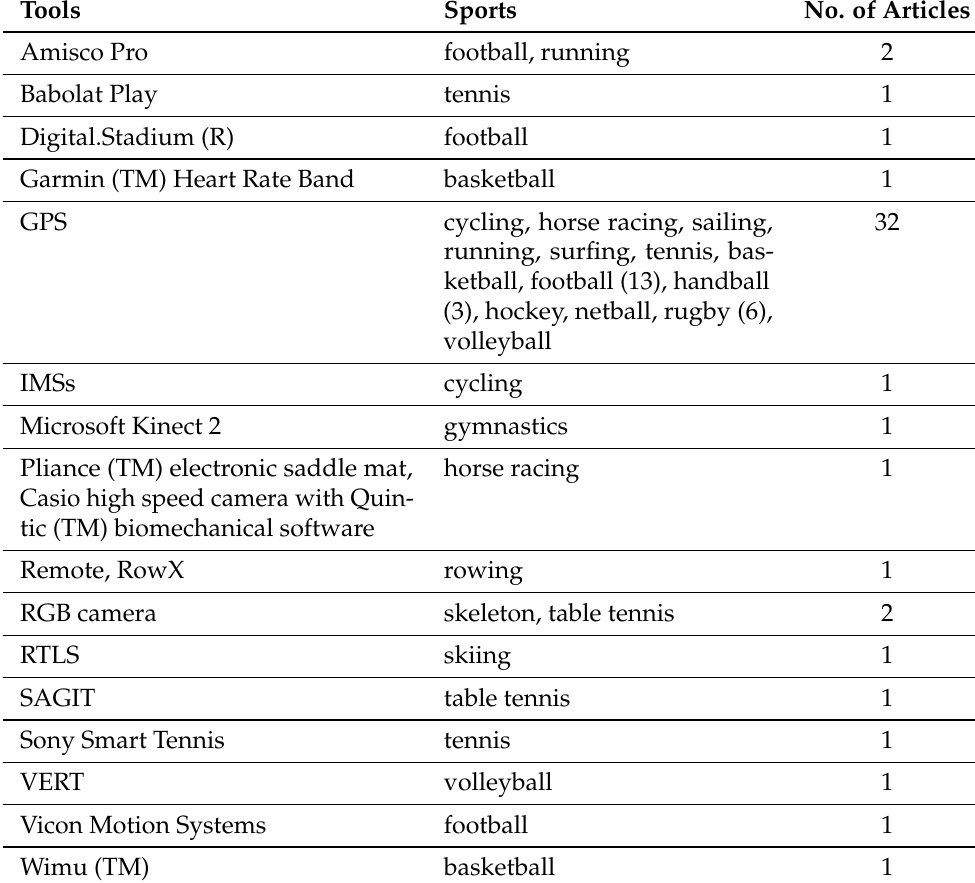
Table 2. Data collection